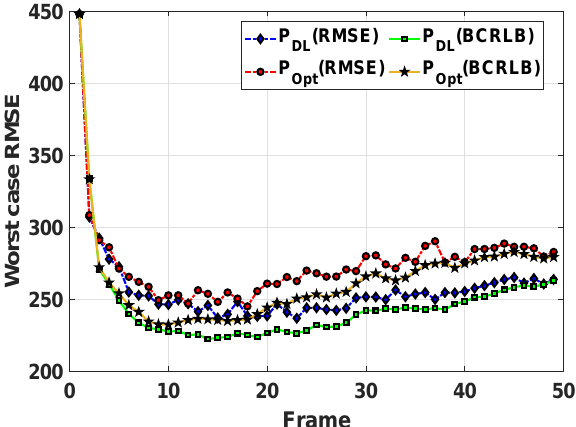
Figure 5. The worst case RMSEs achieved with different power allocation methods versus corre- sponding worst case BCRLBs.